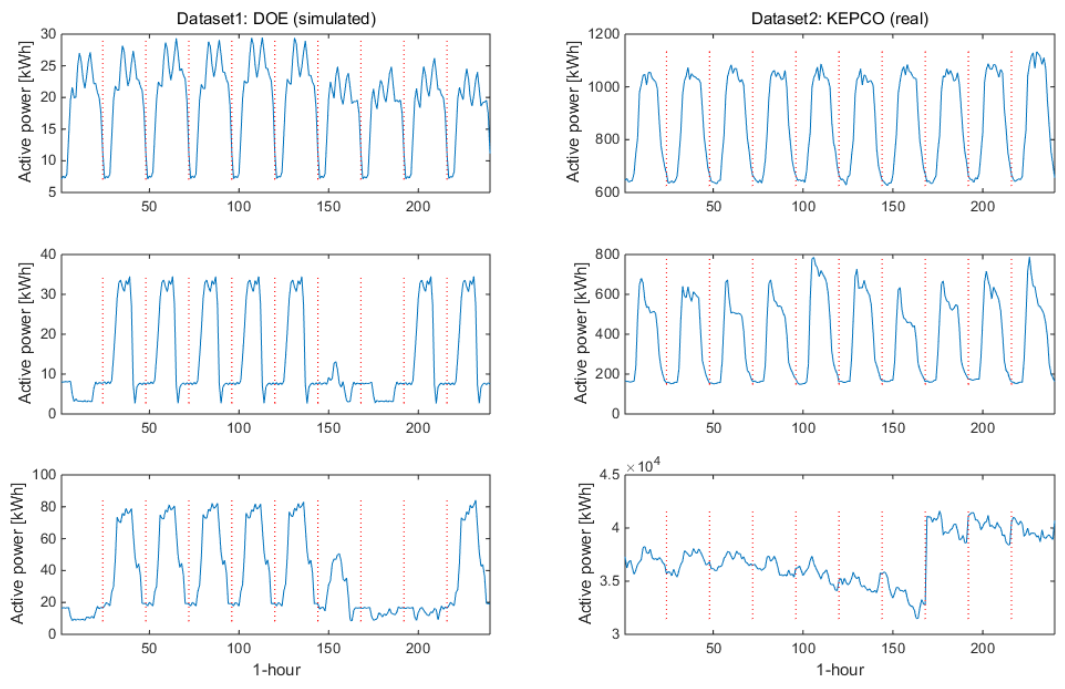
Figure 2. Example of power load data used in the performance evaluation.